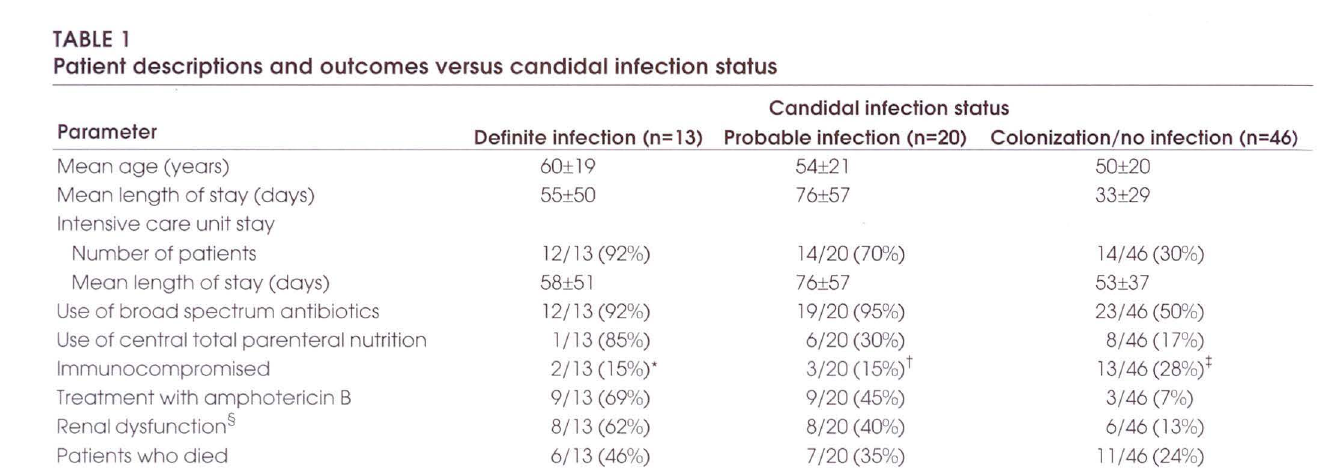
Patient descriptions and outcomes versus candida! infection status Parameter